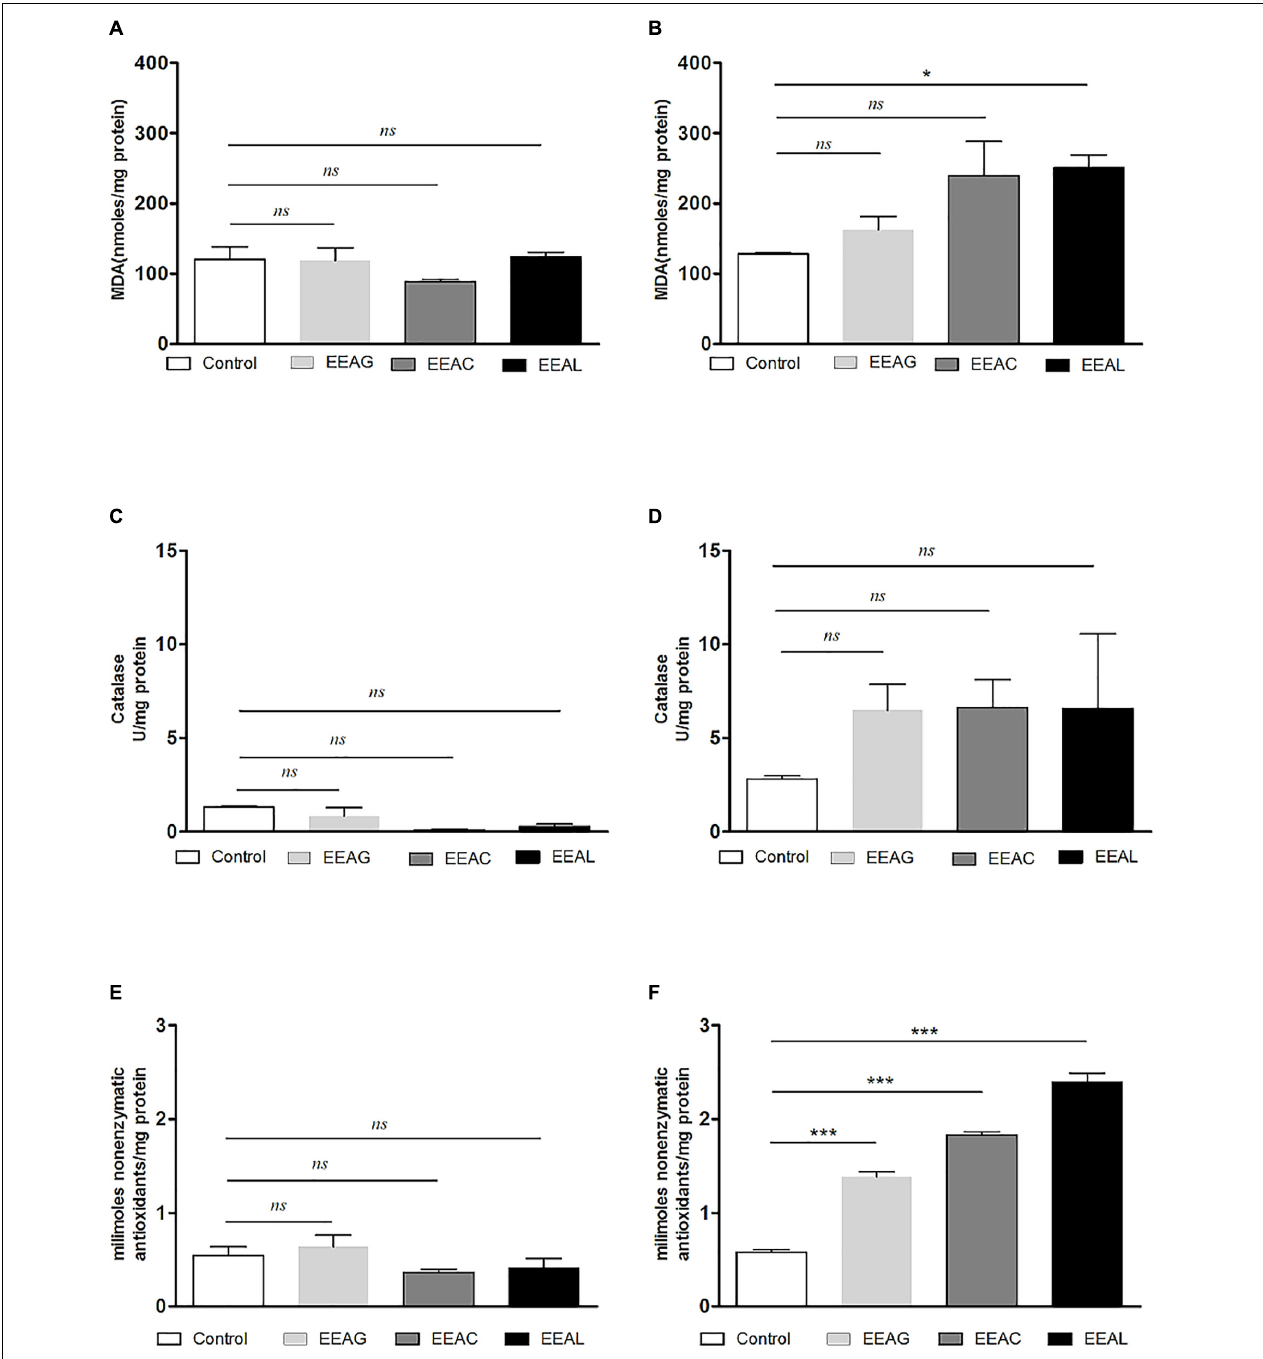
FIGURE 7 | Effects of Ajuga sp. extracts on the oxidative stress generated by C26 colon carcinoma cells. (A,B) Malondialdehyde (MDA) concentration after (A) : IC 50 EEAG, IC 50 EEAC, and IC 50 EEAL treatment and (B) : IC 80 EEAG, IC 80 EEAC, and IC 80 EEAL treatment. (C,D) Catalytic activity of catalase after (C) : IC 50 EEAG, IC 50 EEAC, and IC 50 EEAL treatment, and (D) : IC 80 EEAG, IC 80 EEAC, and IC 80 EEAL treatment. (E,F) Total non-enzymatic antioxidant system levels in the cell lysates obtained from standard culture of C26 colon carcinoma cells after 24 h of incubation with (E) : IC 50 EEAG, IC 50 EEAC, and IC 50 EEAL treatment, and (F) : IC 80 EEAG, IC 80 EEAC, and IC 80 EEAL treatment. One way ANOVA test with Bonferroni correction for multiple comparisons was performed to analyze the differences between the effects of the treatments applied on MDA and non-enzymatic antioxidant defense systems levels and on catalase activity. Control, untreated C26 cells; IC 80 or IC 50 EEAG, cells incubated with 650 µ g/mL or 457.5 µ g/mL A. genevensis ethanolic extract; IC 80 or IC 50 EEAC, cells incubated with 650 µ g/mL or 303 µ g/mL A. chamaepitys ethanolic extract; IC 80 or IC 50 EEAL, cells incubated with 325 µ g/mL or 176.3 µ g/mL A. laxmannii ethanolic extract. (ns, P > 0.05; ∗ P < 0.05; ∗∗∗ P <